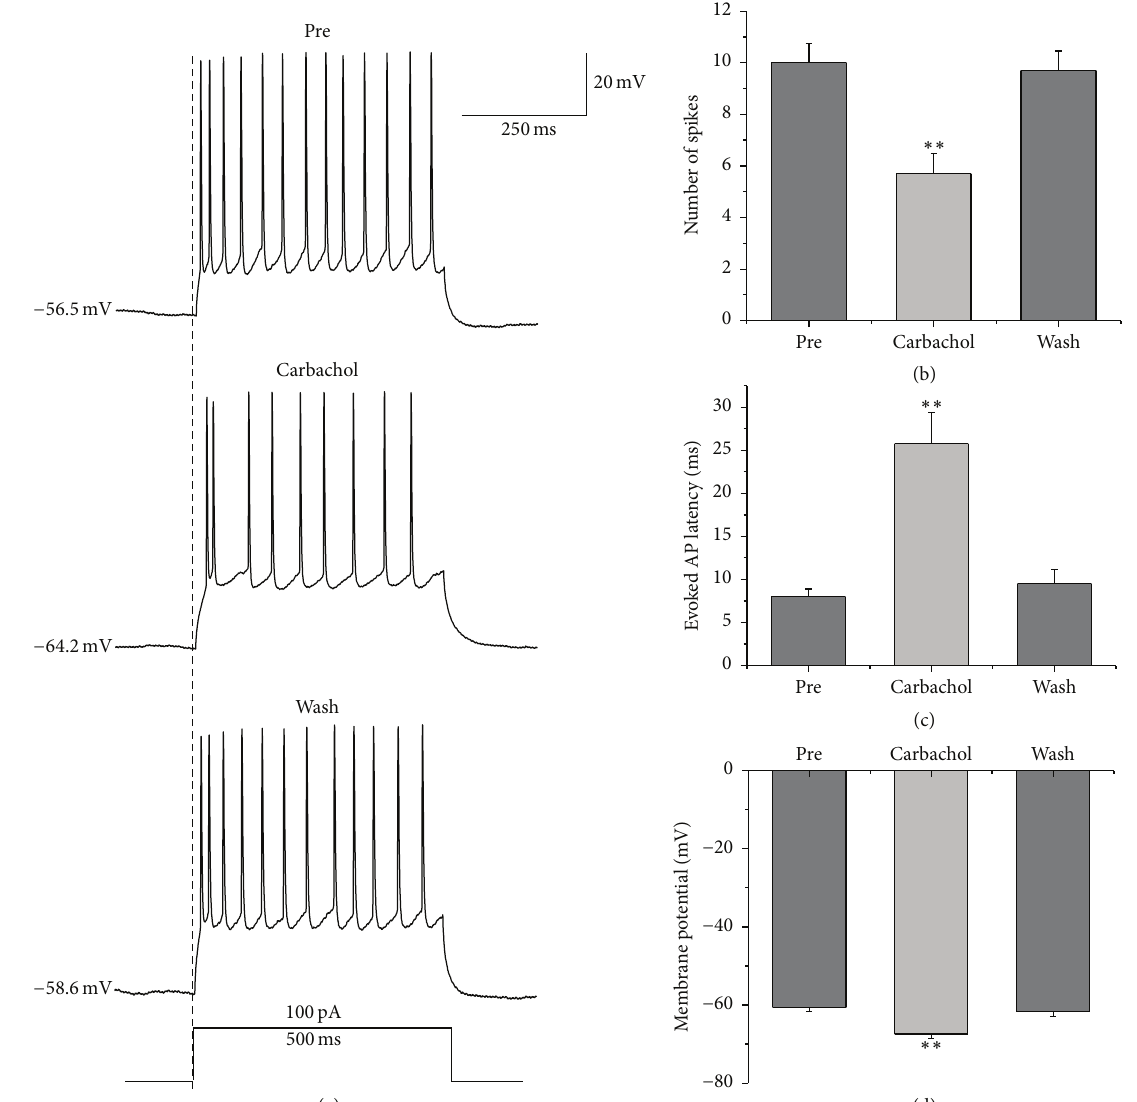
Figure 2: Effects of 30 𝜇 M carbachol on the AP firing of RA projection neurons evoked by a depolarizing stimulus of 100 pA amplitude at 500 ms duration. (a) Sample traces showed that carbachol decreased the number of spikes evoked by depolarizing step pulse and induced membrane hyperpolarization. (b) The number of spikes evoked by depolarizing step pulse was significantly decreased in the presence of carbachol ( 𝑛 = 23 ). (c) The evoked AP latency was significantly increased in the presence of carbachol ( 𝑛 = 20 , the latency is determined fromthetimebetweentheonsetofthestimulusandthefirstevokedAPforeachcell).(d)Membranepotentialwassignificantlyhyperpolarized in the presence of carbachol ( 𝑛 = 23 ). ∗∗ means 𝑝 < 0.01 , paired 𝑡